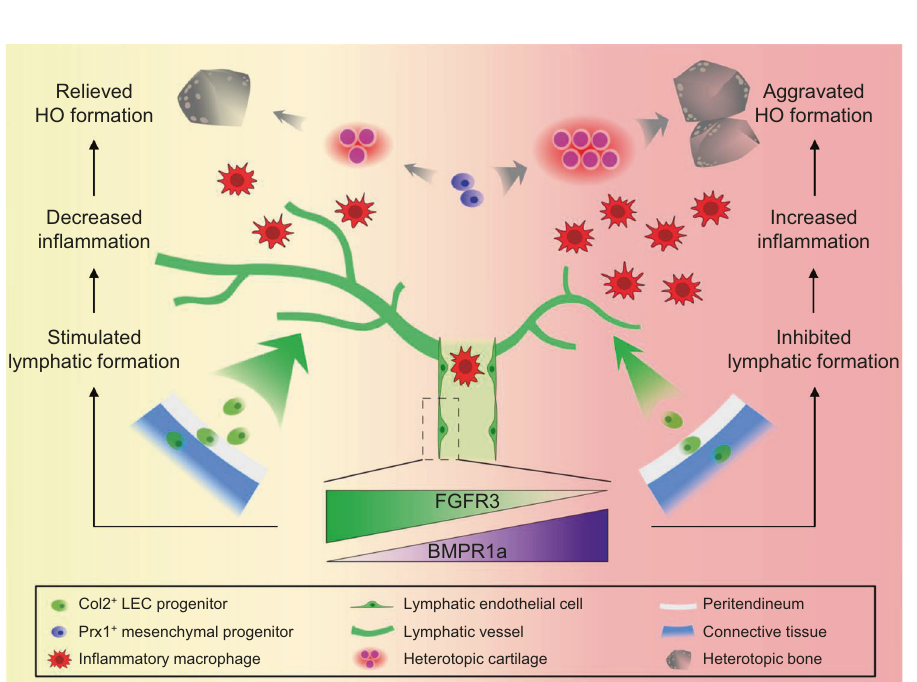
Fig. 7 Schematic diagram describing the role of FGFR3 and lymphatics in acquired HO formation. Col2 + LEC progenitors in the peritendineum as well as adjacent connective tissues adopt LEC fate in the traumatically injured Achilles tendon at the onset of HO development. Downregulated FGFR3 expression in LECs associated with in fl ammatory milieu inhibits local lymphatic formation via upregulating BMPR1a signaling, which further increases local in fl ammatory levels and subsequently aggravates HO